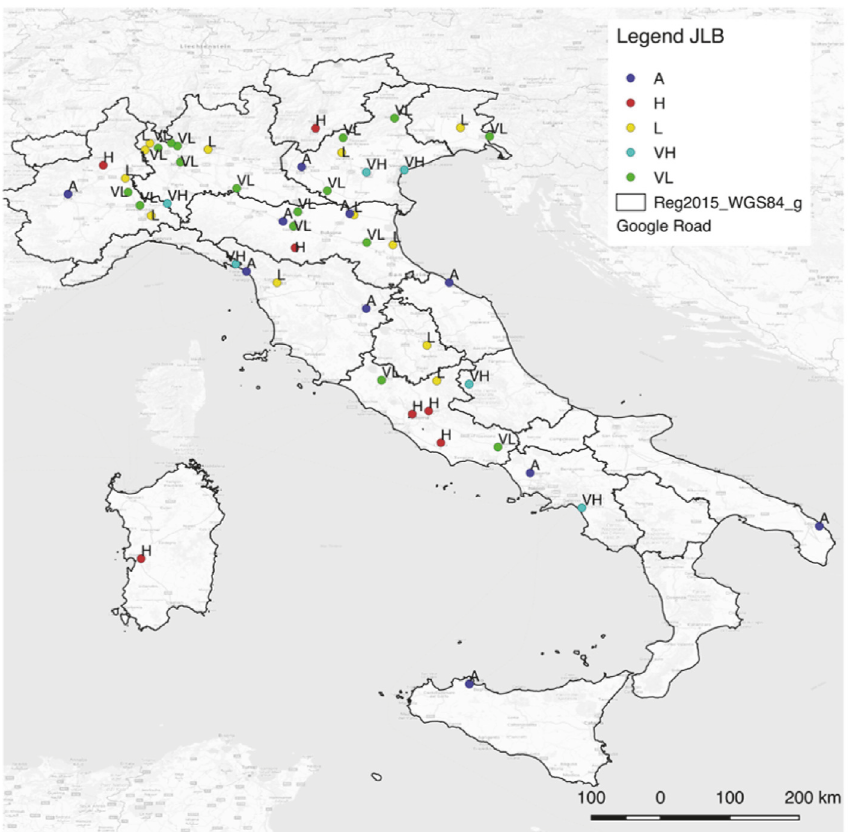
Figure 7: MCSDA implementation for JLB: spatial mapping.